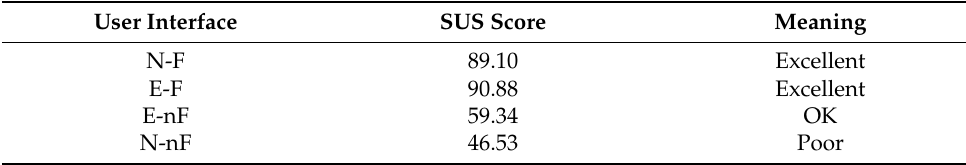
Table 19. SUS scores after completing the ten random test